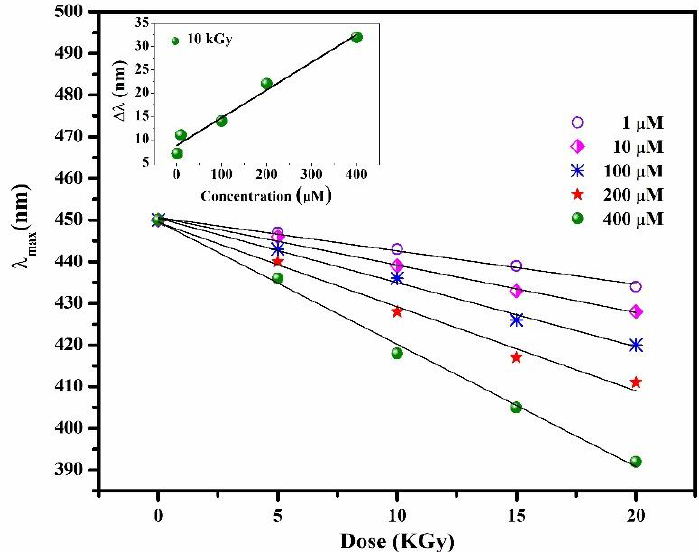
Figure 3. The main absorption peak wavelength (λ max ) of the B-co-MP in THF versus gamma doses at different concentrations.